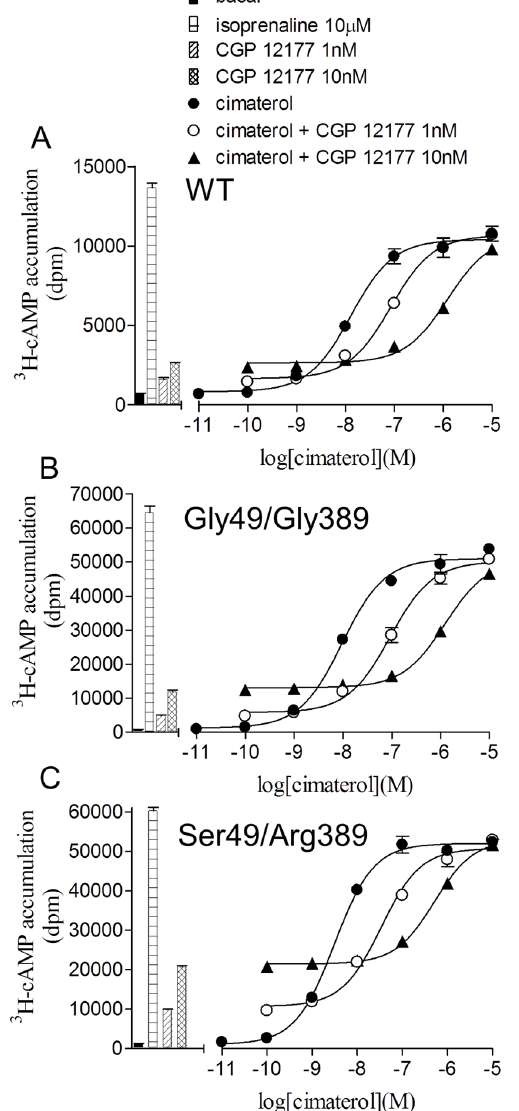
Figure 3. Inhibition of cimaterol-induced 3 H-cAMP accumula- tion responses by CGP 12177. 3 H-cAMP accumulation in response to cimaterol in A wildtype cells, B Gly49/Gly389 cells and C Ser49/ Arg389 cells in the absence and presence of CGP 12177. Bars represent basal 3 H-cAMP accumulation, that in response to 10 m M isoprenaline and that in response to 1 nM and 10 nM CGP 12177. Data points are mean 6 s.e.mean of triplicate determinations and these single experiments are representative of 4 separate experiments in each case. Here, CGP 12177 inhibits the catecholamine conformation response with high affinity in all three receptor variants.